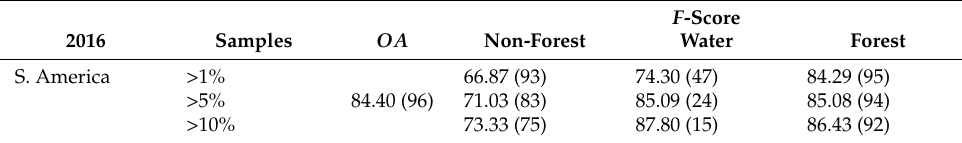
Table 1. Performance comparison between TanDEM-X mosaic over the Amazonas rainforest of 2016 and Sentinel-2 (S2). The OA is presented for each mosaic. The number of evaluated geocells is specified in brackets. The F -score is shown for the three land cover classes: non-forest, water and forest. For each case, only geocells with a certain amount of samples belonging to each land cover class (>1%, >5% and >10%) have been considered. The overall amount of pixels belonging to each class has been estimated from the external map used in the comparison.